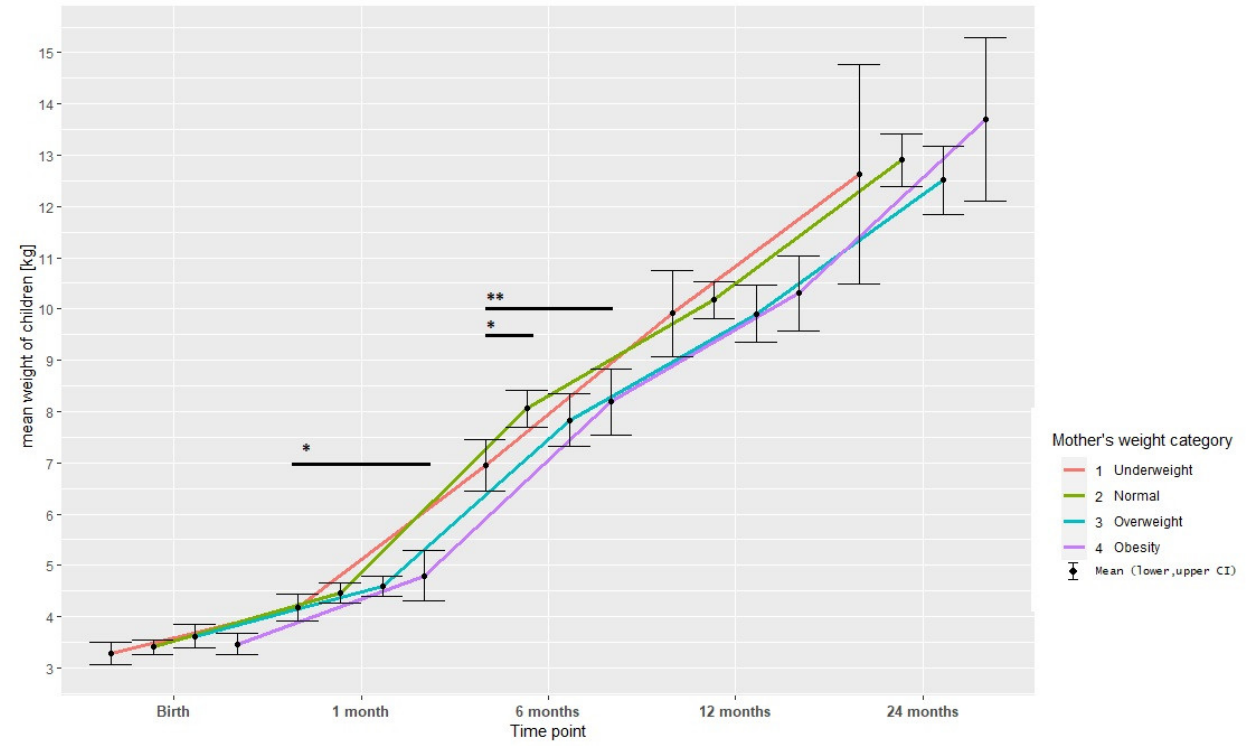
Figure 3. Child’s weight gain over time among the maternal BMI group. Observed differences: 1 month between groups underweight and obesity, 6 months between groups underweight and obe- sity and underweight and normal. p values obtained in post hoc analysis (Dunn's test): * p < 0.05, ** p < 0.001.